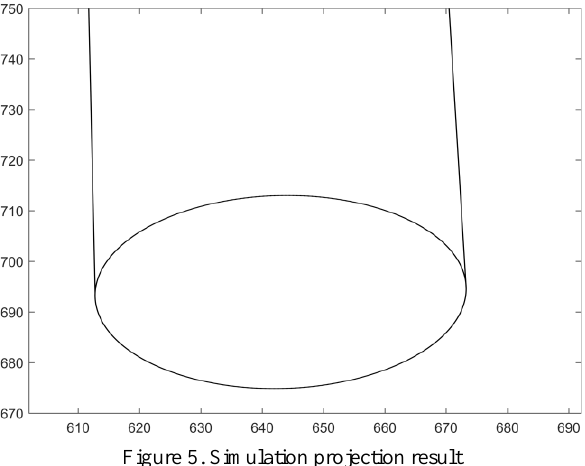
Figure 5. Simulation projection